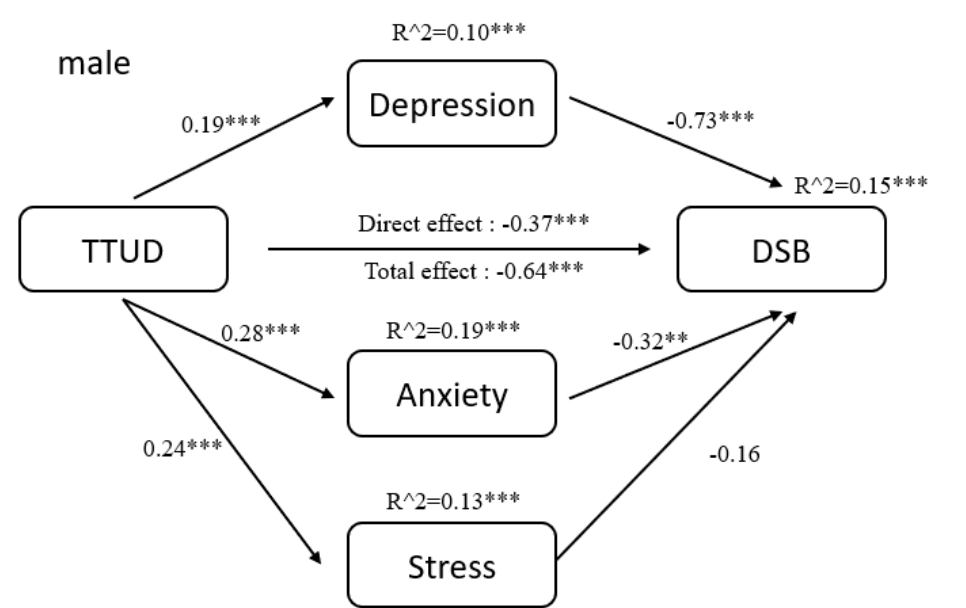
Figure 5. Structural model of backward digit span test for male participants. ** p < 0.01, *** p < 0.001.